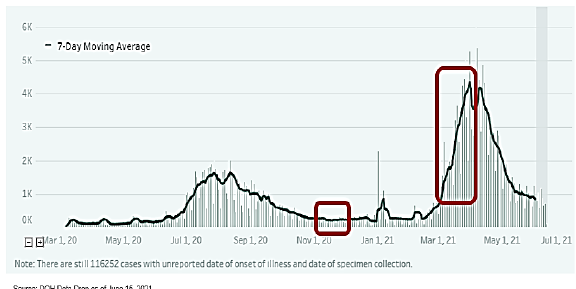
Figure 4. Reported confirmed daily COVID-19 cases in NCR.